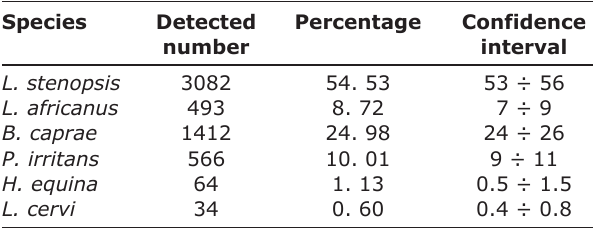
Table-1: Relative proportion of parasitic insect species infesting domestic goats in Bulgaria n = 5651.